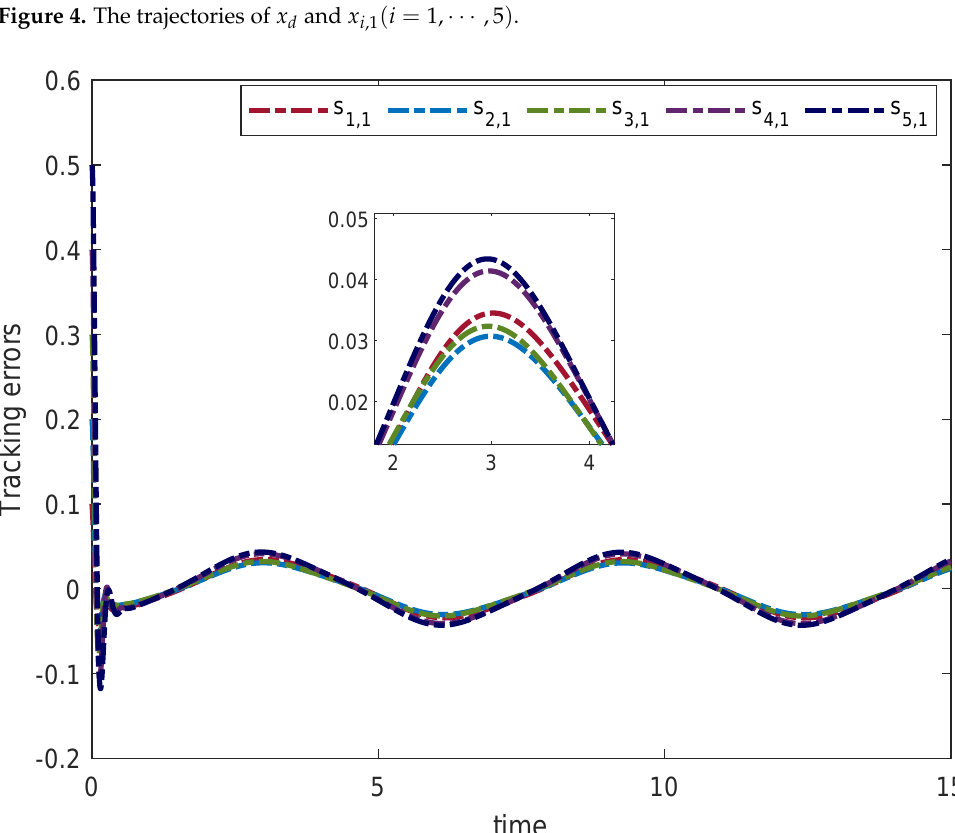
Figure 4. The trajectories of x d and x i ,1 ( i = 1, · · · ,5 ) .